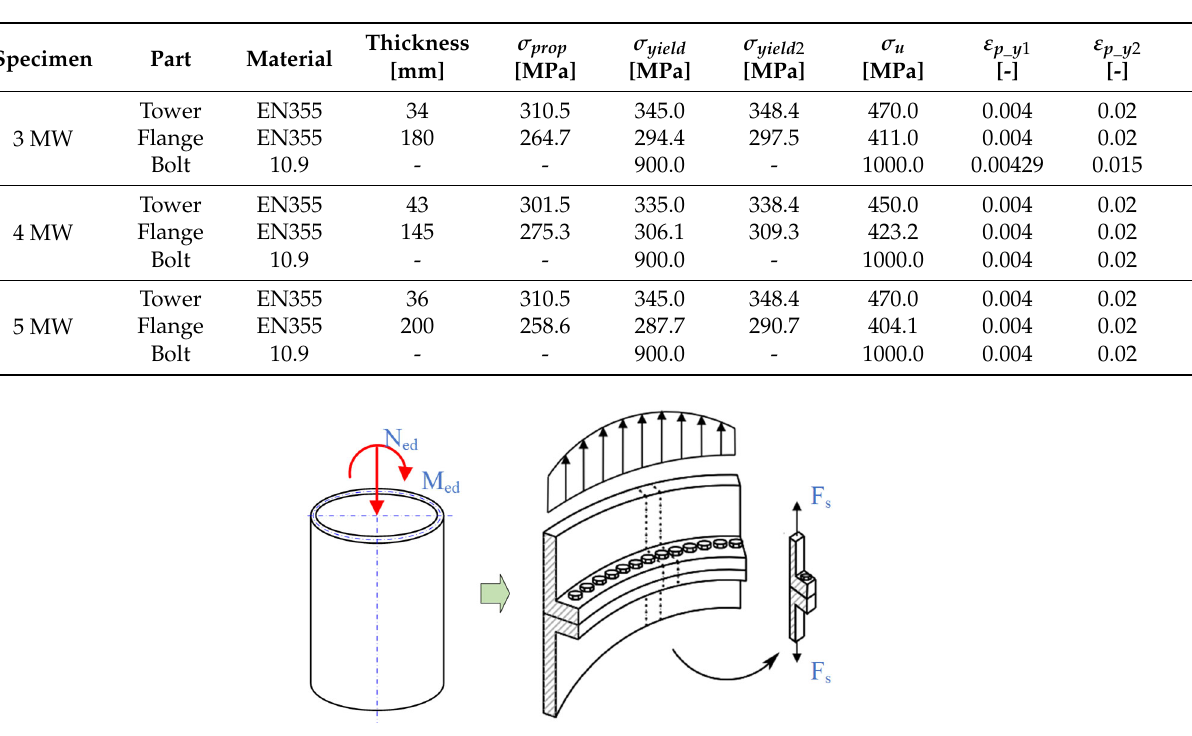
Figure 3. Stress–strain curve [23]. Table 2. Material properties.